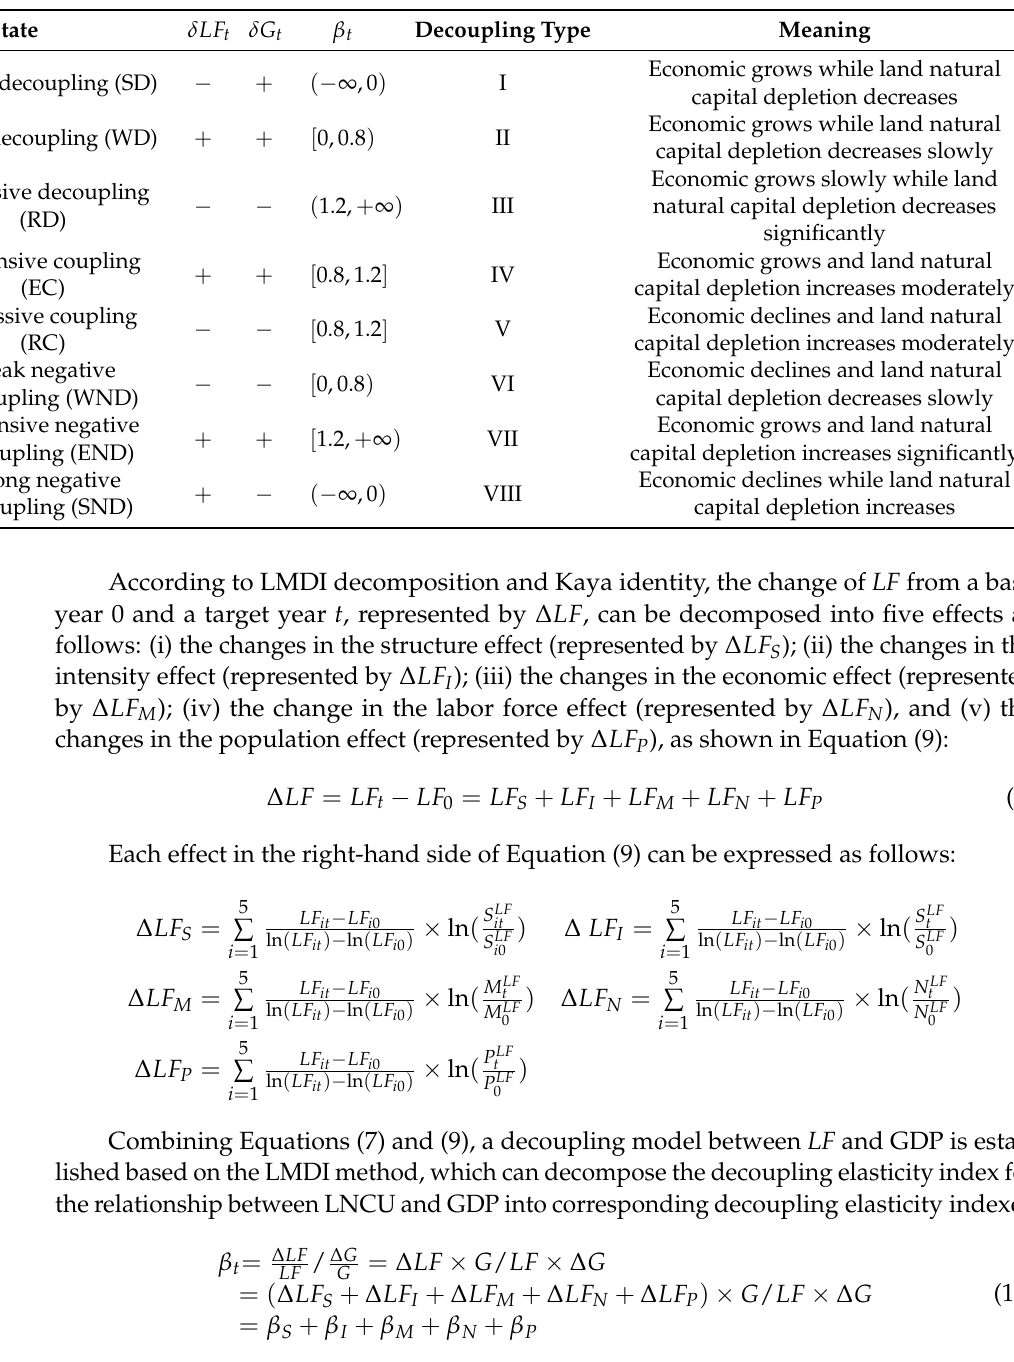
Table 1. Six decoupling